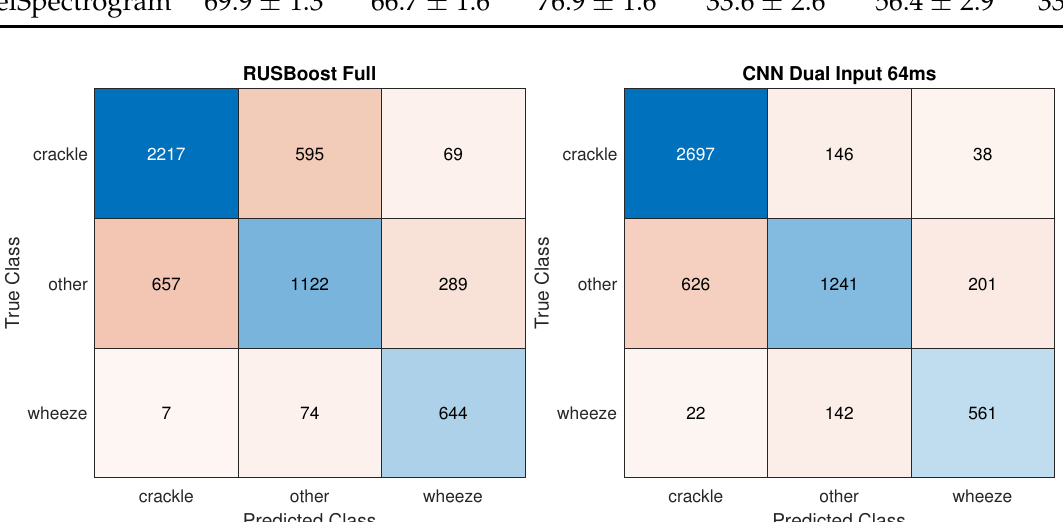
Figure 4. Confusion matrices for the best traditional and deep learning models on the 3 Class task—-training: variable duration; testing: variable